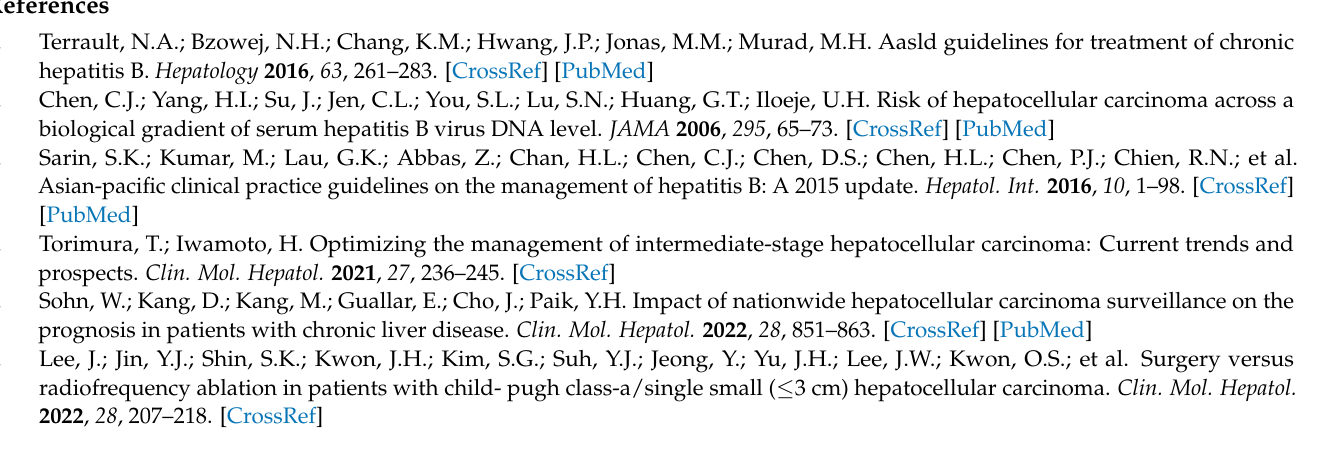
selection. Table S1: Summary of HCC prediction models [14,16,17,19,20,32–36,51]. Table S2: Univari- ate Cox regression analysis for the development of hepatocellular carcinoma. Table S3: Comparison of predictive performance between the modified REACH-B and other HCC risk prediction mod- els. Table S4: Baseline clinical characteristics of the study population who underwent transient elastography after 1 year of antiviral therapy and did not develop HCC within 18 months after antiviral